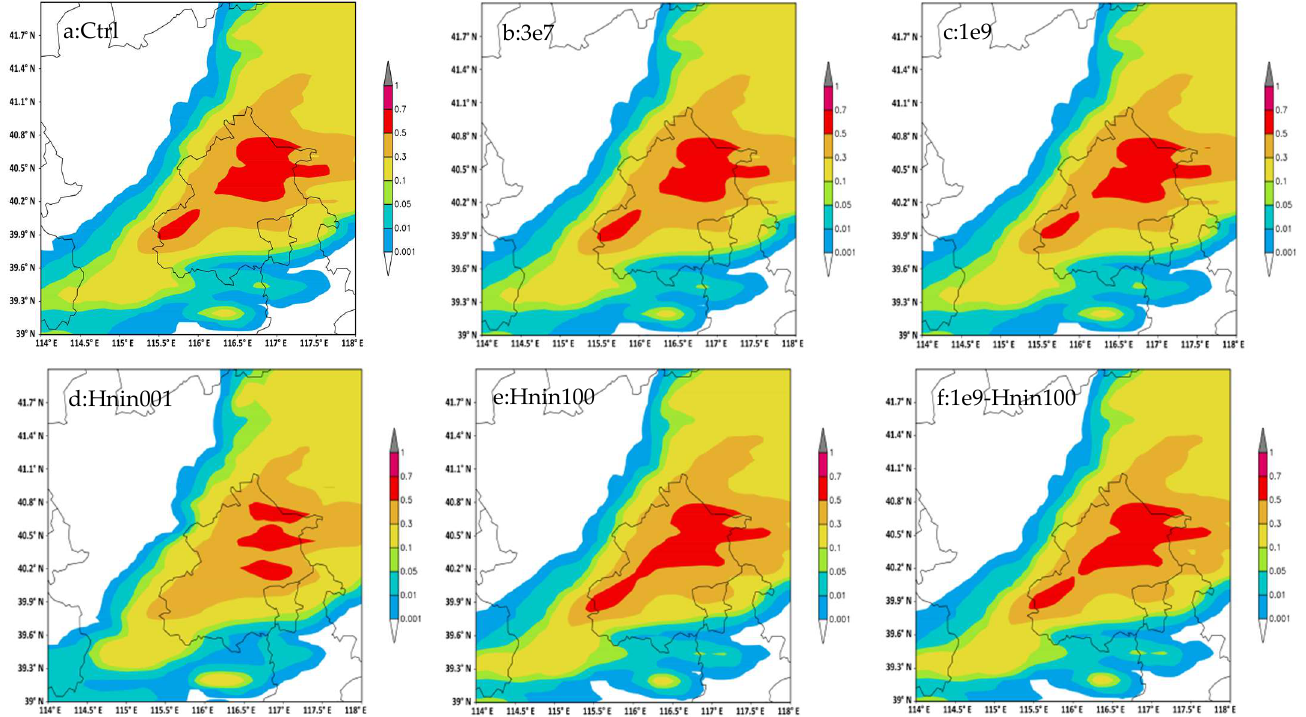
Figure 5. Horizontal distribution of total mass content of water substances of the control and five sensitivity simulations at approximately 5 km height (g/kg) on 17 March, 11 UTC, 2012.